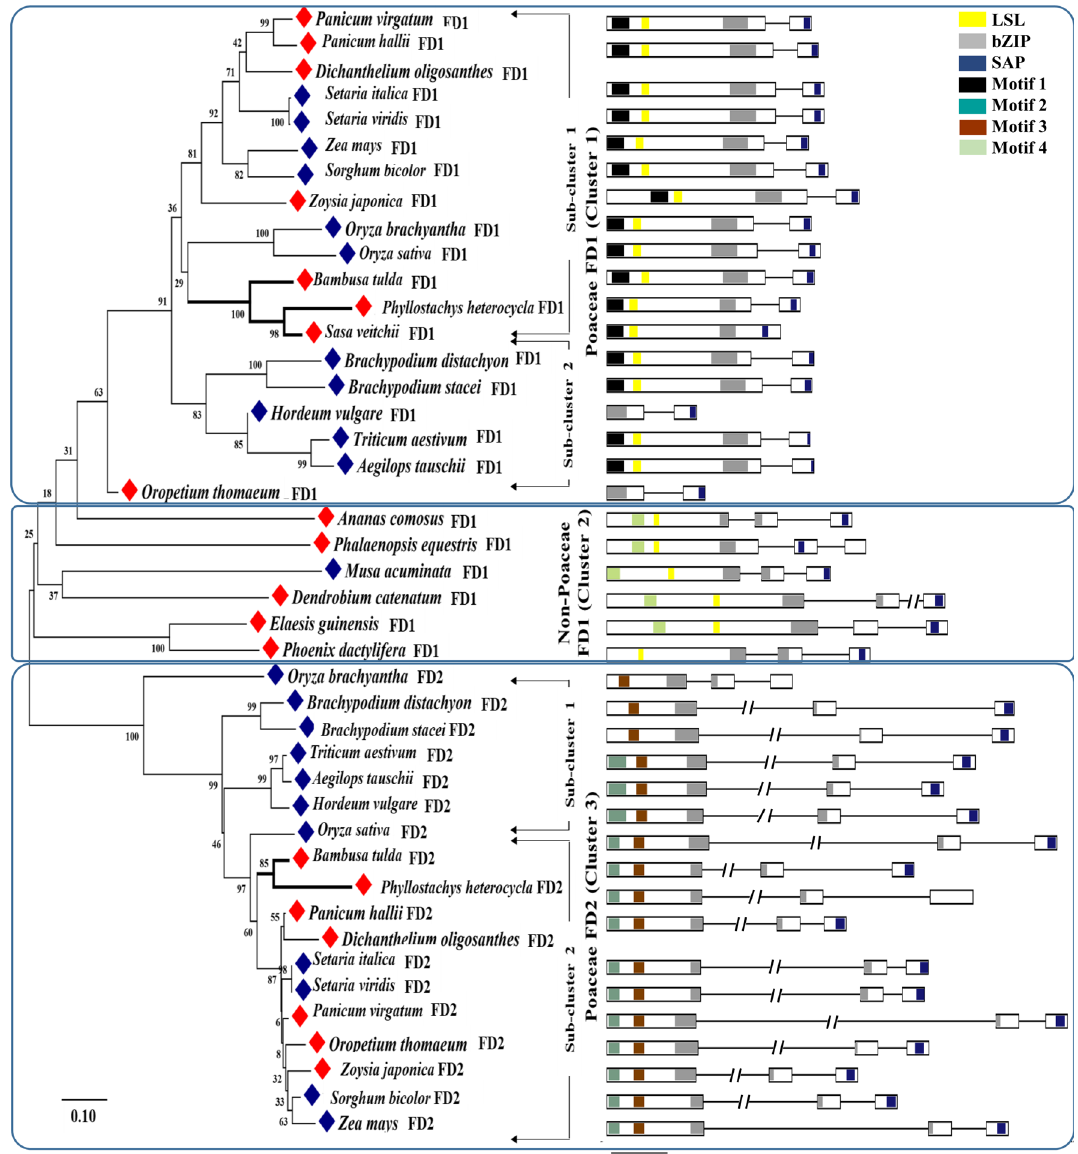
Figure 1. Phylogenetic analysis and predicted gene models of FD homologs identified in monocotyledonous plants. The Neighbour Joining (NJ) tree of the FD homologs was constructed with the full-length protein sequences by Mega 7.0 using default parameters and bootstrap value 2000. In the gene structures exons were marked as rectangles having conserved motifs marked in solid boxes and introns as solid lines. Annual species were marked in blue and perennials in red rhomboids. The motifs conserved are M 1 [MEDD(E/D) DMW(A/G)XTSSPSASPP], M 2 [NYHHYQMAV(A/H)AA], M 3 [(L/M/V)SGCSSLFSIS(S/T)], M 4